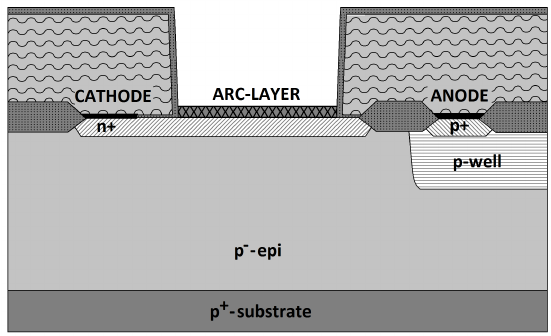
Figure 1. Cross-section of the integrated pin photodiode with anti-reflective coating (ARC) layer and low-doped, 15µm thick epitaxial p-